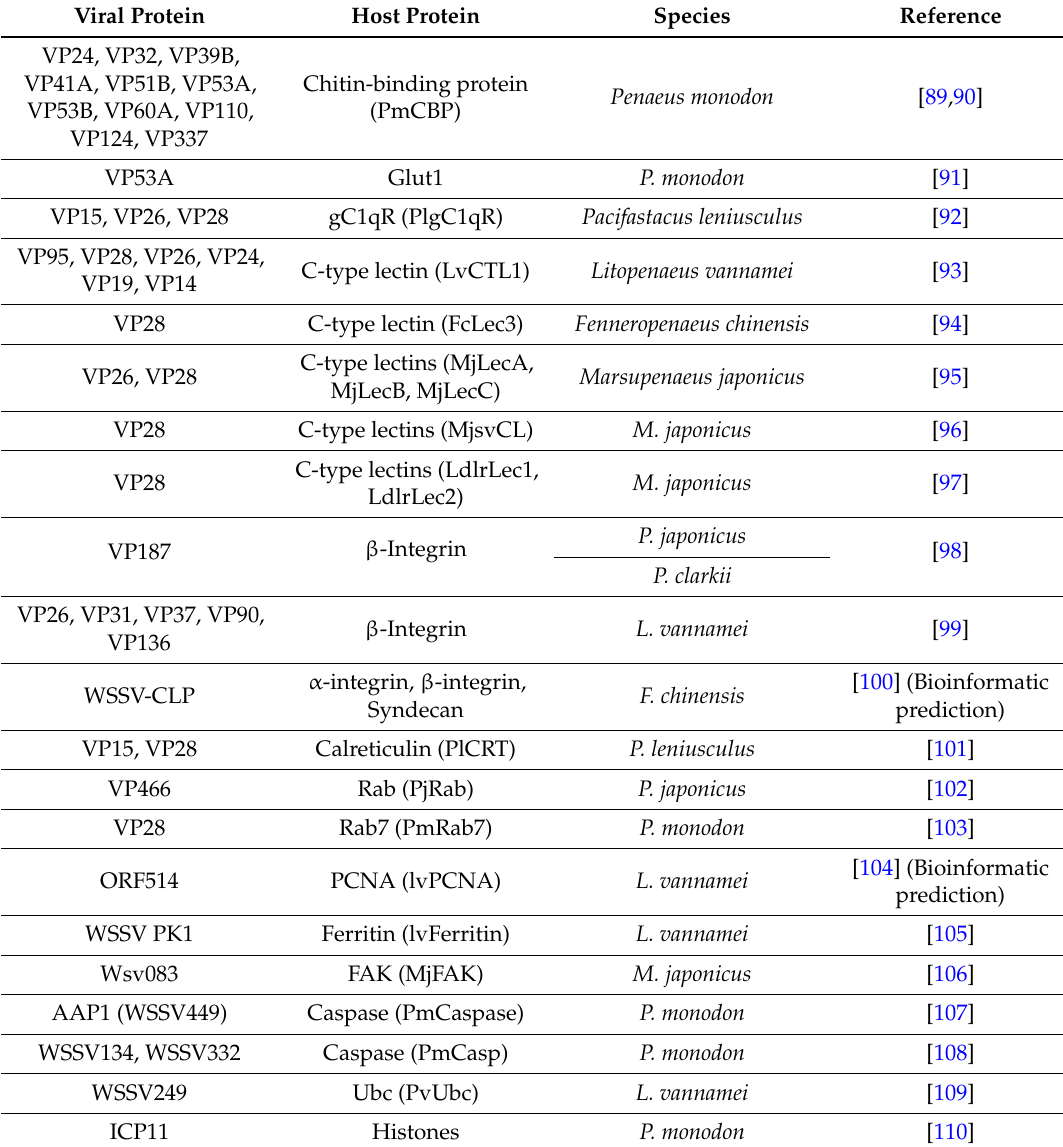
Table 1. Established WSSV–host protein